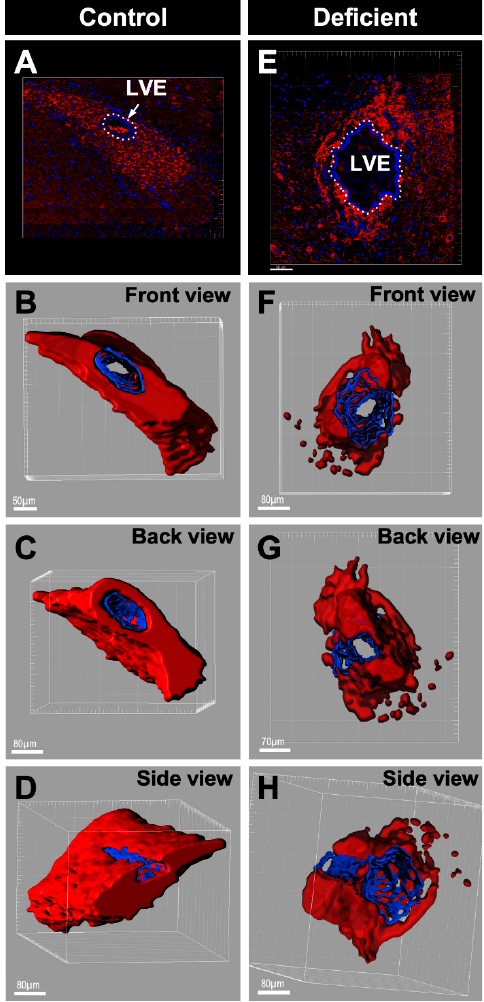
Figure 6. Three-dimensional reconstruction of the LVE and surrounding neuroblasts of control and vitamin-C-deficient guinea pigs. 3D reconstruction of Z-stacked coronal sections of the LVE of con- trol guinea pigs and guinea pigs with 21 days of vitamin C deficiency labeled with anti- β III tubulin (red, 1:1000) and hematoxylin (blue). ( A ) Z-stacked coronal sections of the LVE of control guinea pig. ( B – D ) Three different rotations of the 3D-reconstruction of the Z-stacked coronal sections in image A. ( E ) Z-stacked coronal sections of the LVE of guinea pigs with 21 days of vitamin C defi- ciency. ( F – H ) Three different rotations of the 3D-reconstruction of the Z-stacked coronal sections in image E. LVE: Lateral ventricle extension. Scale bar for images ( A ) and ( E ): 50 μ m.